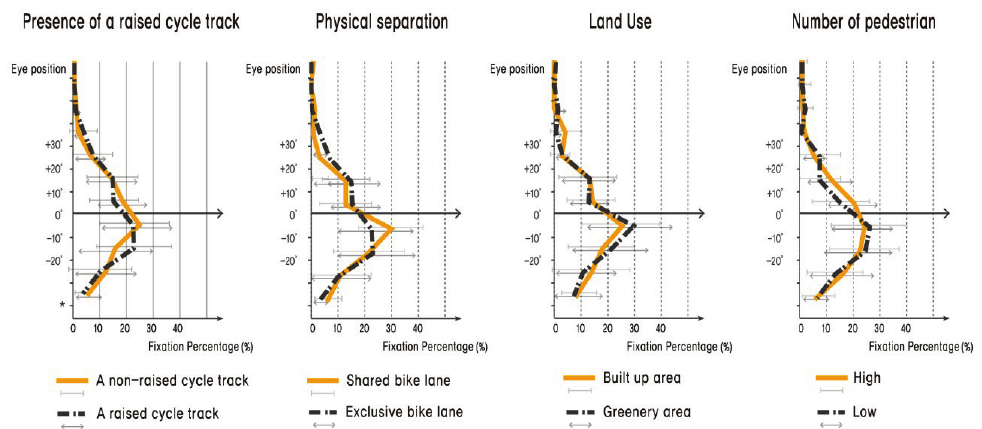
Figure 6. Vertical spread of fixation duration (%) for the presence of a raised cycle track, physical separation, land use, number of pedestrian. And * presents to have significant difference